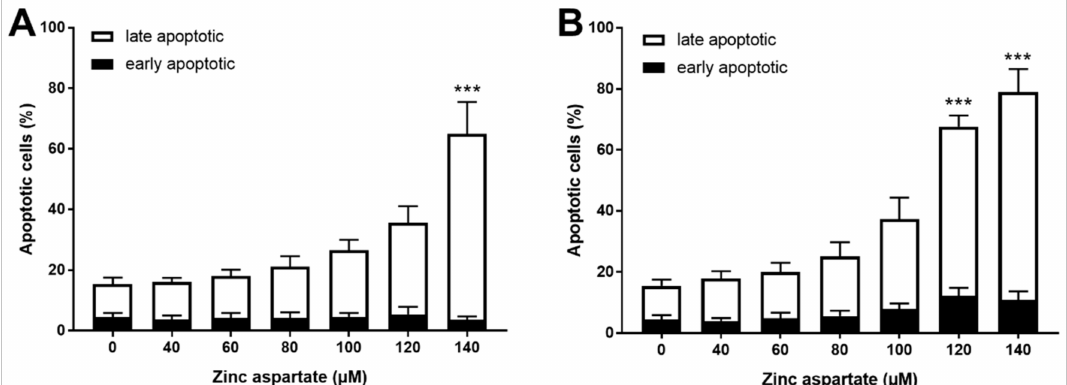
Figure 3. Zinc aspartate induced late apoptosis in freshly stimulated and pre-activated T cells. Resting human T cells were freshly stimulated ( A ) or pre-activated for 48 h ( B ) with anti-CD3/CD28 antibodies and cultured with increasing concentrations of zinc aspartate. Cells were stained after 72 h with AnnexinV-FITC/propidium iodide (PI) for flow cytometric analysis. Quantification of early and late apoptotic cells of n = 4 independent experiments are shown. Statistical analysis was performed with One-Way ANOVA and Dunnett’s Multiple Comparison Analysis Test as post hoc test. (*** p < 0.001).